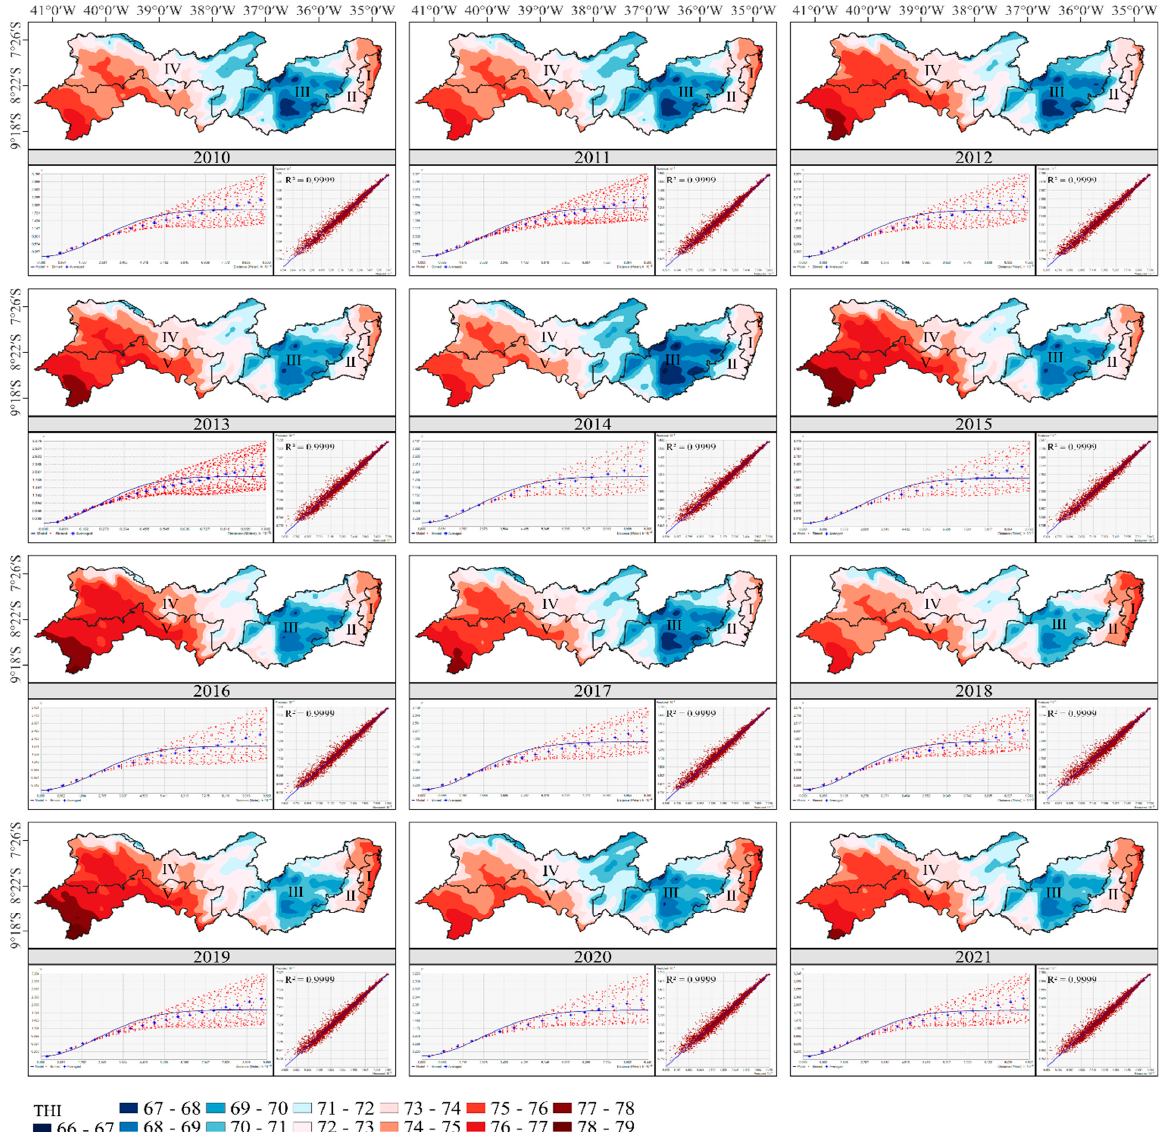
Figure 3. Kriging maps of THI, experimental semivariograms, and cross-validation for the years 2011 to 2021 in the Metropolitana, Zona da Mata, Agreste, Sertão, and São Francisco mesoregions of Pernambuco state, Brazil.